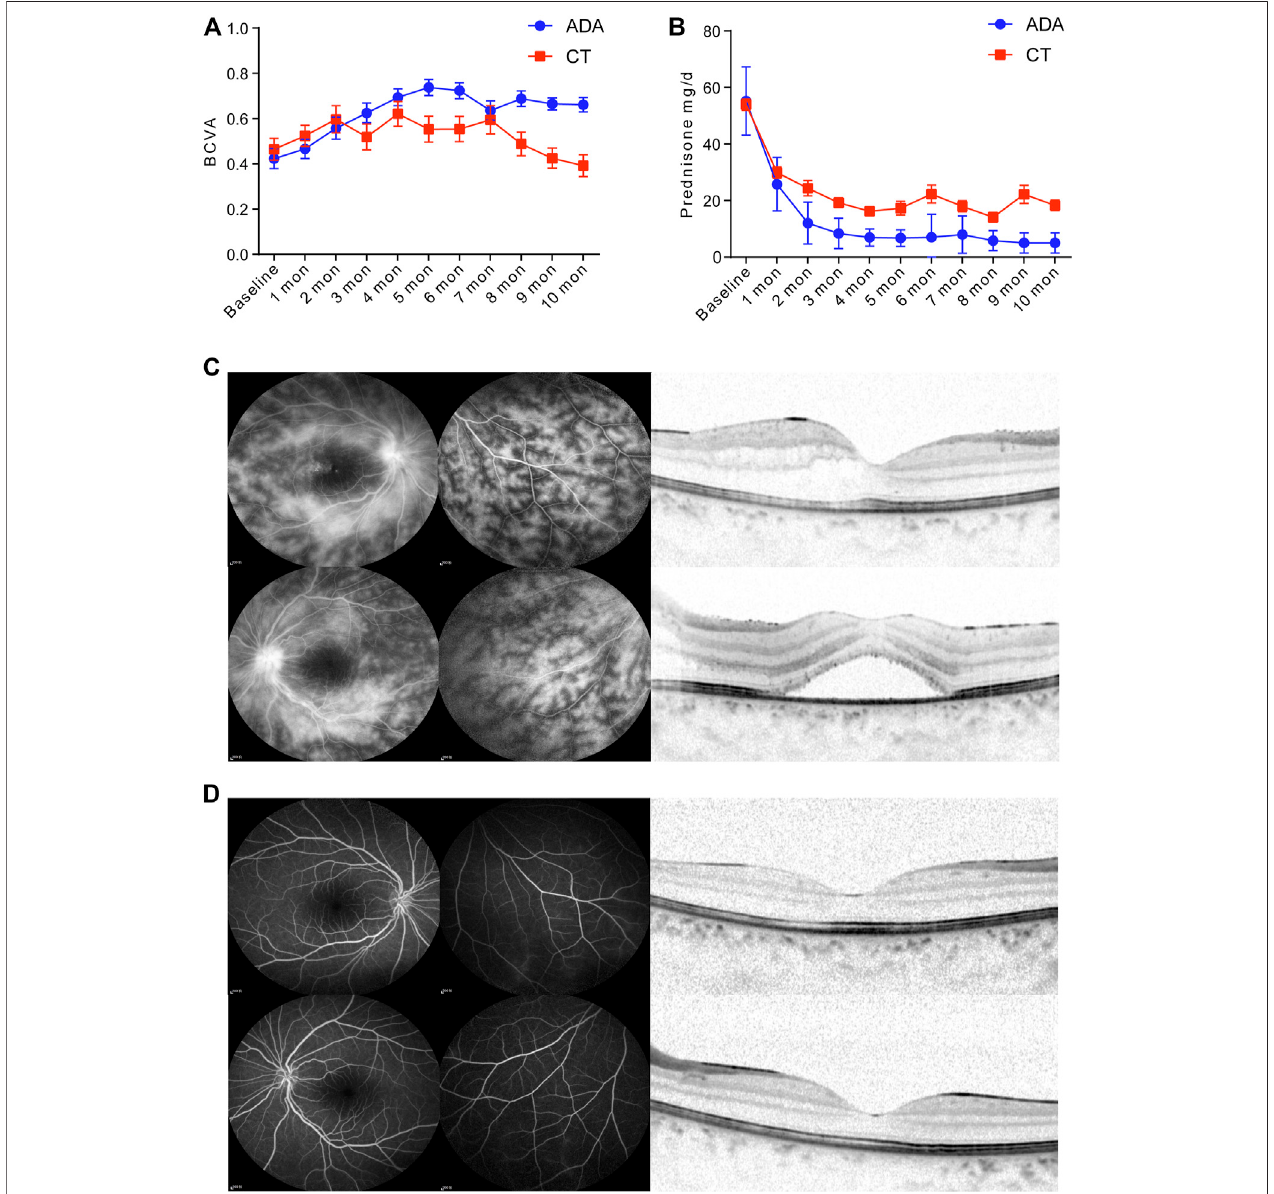
FIGURE1|(A) BCVAoftreatment-NaïvepatientswithBUretinalvasculitisintheCTgroupandADAgroupatmonthlyregularvisits. (B) Dailyglucocorticoiddosage of patients in the CT group and ADA group at monthly regular visits and at fi nal follow-up. In CT group, 20 (83.3%) patients proceeded oral glucocorticoid with dose of 22.63 ± 20.83 mg/d, while in ADA group, 11 (53.4%) patients proceeded oral glucocorticoid with dose of 7.50 ± 2.96 mg/d. (C) A 10-year-old female BU patient with a BCVA of 0.4 (OD) and 0.16 (OS). FA imaging (10 min) showed (C-left panel) severe “ fern-like ” pattern change and (C-right panel) OCT scan observed edema in the macula with thicknesses of 277 and 483 μ m in the right (top) and left (bottom) eyes, respectively. (D-left panel) FA imaging (10 min) of the same patient after ADA administration at the 5-months follow-up shows signs of vasculitis disappearance. The BCVA of the patient improved to 0.63 (OD) and 0.63 (OS). (D-right panel) Normalization of morphology in macular region in OCT scan after ADA